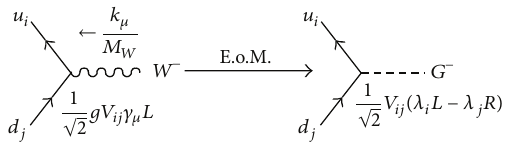
Figure 2: Deriving the Yukawa coupling, that is, Goldstone boson coupling to quarks, from purely left-handed gauge couplings, where E.o.M. stands for equation of